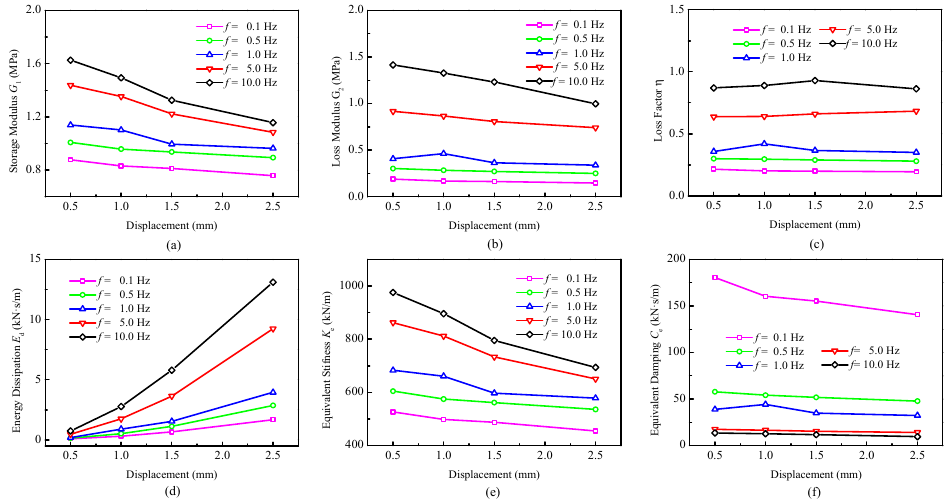
Figure 5. Dynamic properties parameters with varying frequencies. ( a ) Storage modulus. ( b ) Loss modulus. ( c ) Loss factor. ( d ) Energy dissipation. ( e ) Equivalent stiffness. ( f ) Equivalent damping.